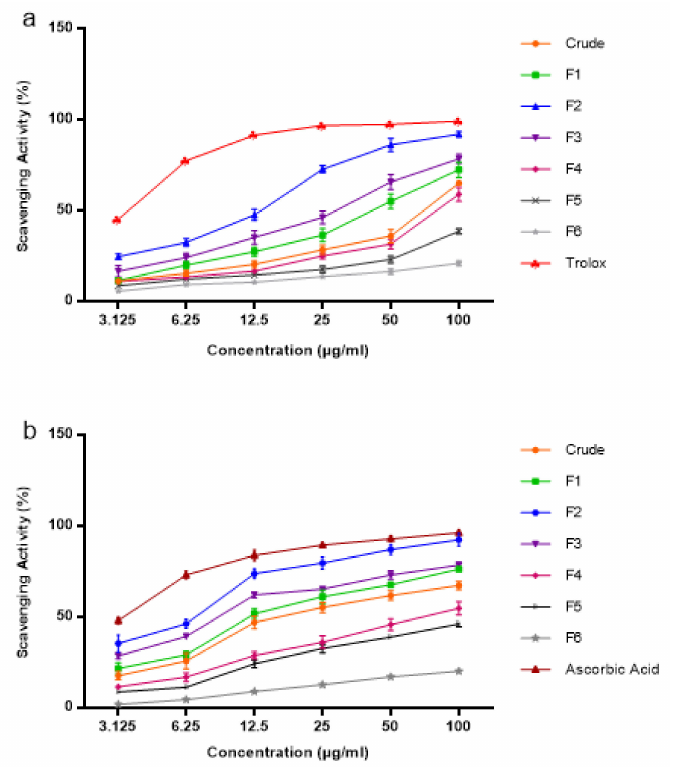
Figure 7. Activity of OS and its fractions in two different assays: ( a ) 2,2 (cid:48) -Azino-bis(3-Ethylbenzothiazoline- 6-sulphonic acid) (ABTS) scavenging activity (%) and ( b ) 2,2-Diphenyl-1-picrylhydrazyl (DPPH) scavenging activity (%). Each data represent the mean ( n = 3) with standard